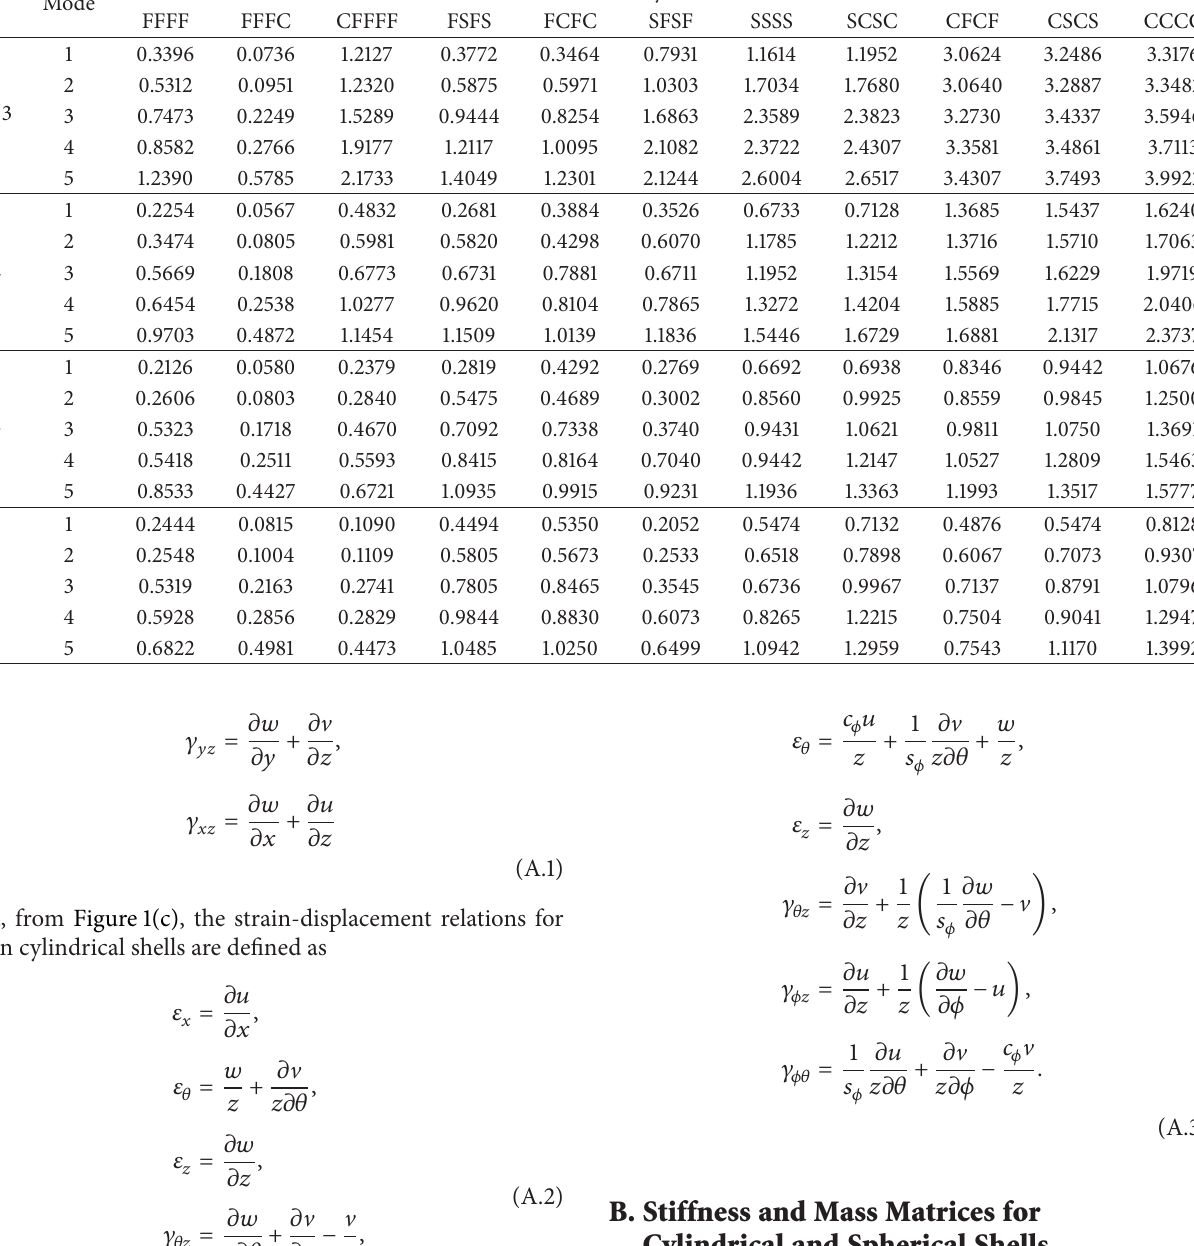
Table 14: The first five frequency parameters Ω = 𝜔𝑅√𝜌( 1 − 𝜇 2 )/𝐸 of an open isotropic spherical shell with various boundary conditions and meridian dimensions ( 𝜙 1 = 5𝜋/6 , 𝜃 0 = 𝜋 , 𝑅 = 1 m, ℎ/𝑅 = 0.3 , 𝐸 = 210 GPa, and 𝜇 = 0 .